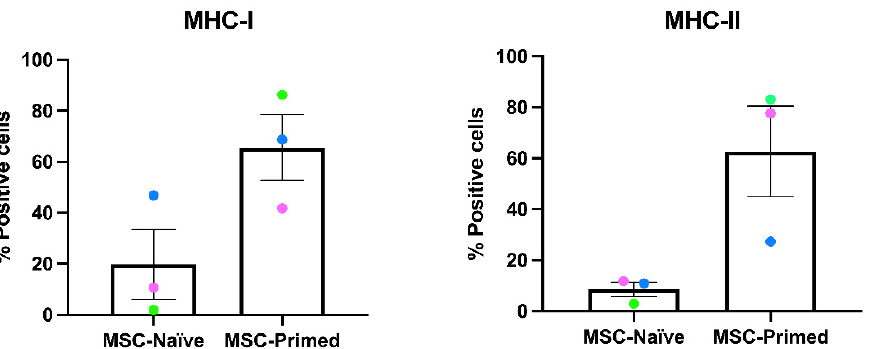
Figure 2. Mean ± S.E.M ( n = 3) of the percentage of MSC before (MSC-naïve) and after being exposed to proinflammatory cytokines (MSC-primed) positive for the surface markers MHC type I and MHC-II determined by flow cytometry. Each colour dot represents the value for each donor (D1, green dot; D2, pink dot; D3, blue dot). These results corroborated the increased expression of both MHC type I and II in MSC-primed, and the inter-individual variability for MHC expression.